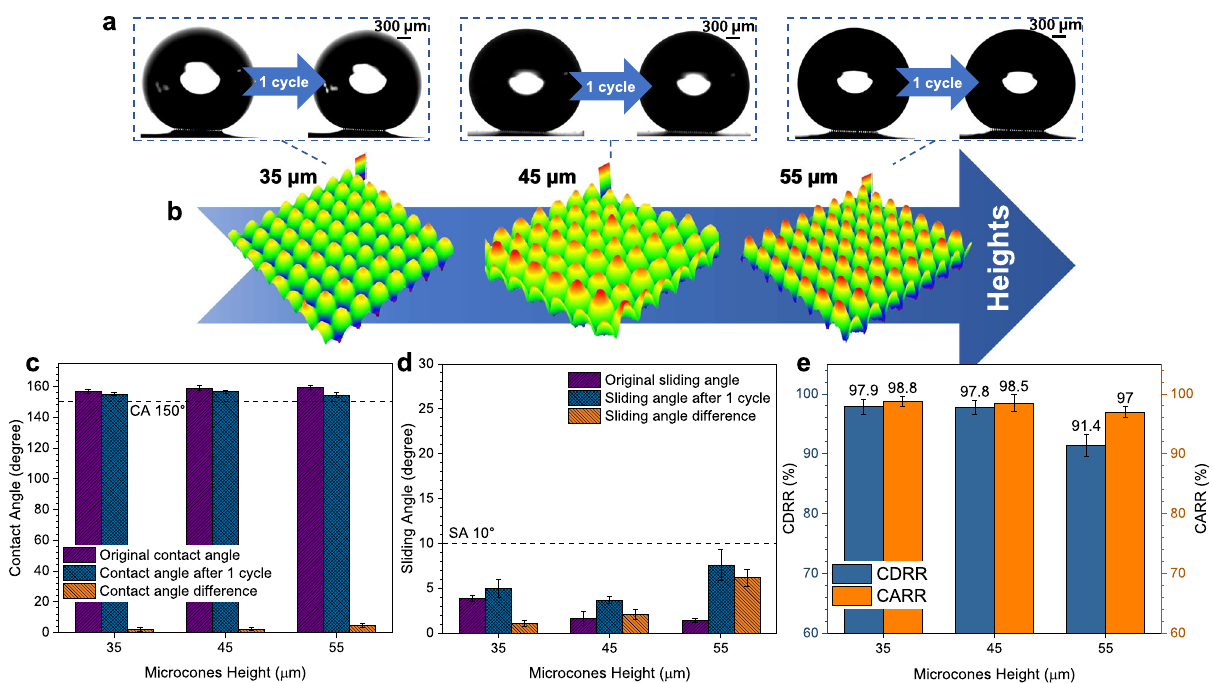
Fig. 8 Effects of different microcones heights on the recovery of CB state. a State changes of droplets on the MCNP surfaces with different microcones heights after an icing & melting cycle. b Morphology evolutions of micro-nanostructure with different microcones heights. By adjusting laser processing parameters (Supplementary Table 2), we achieve precisely tunable heights and pitches of the micro-nanostructure on the MCNP surfaces. Two kinds of surfaces are fabricated: the surfaces with different microcones heights and constant pitch and the surfaces with different microcones pitches and constant height (Supplementary Figs. 20 – 22 and Supplementary Method 2). In the fi gure, microcones pitch is fi xed at 35 μ m while microcones heights vary from 35 μ m to 55 μ m. c – e Effects of different microcones heights on the contact diameter recovery rates (CDRR), the contact angle recovery rates (CARR), contact angles (CA), and sliding angles (SA), respectively. The CA 150° and SA 10° boundaries of superhydrophobicity are indicated with the black dashed line. Data are mean ± s.d. from at least three independent